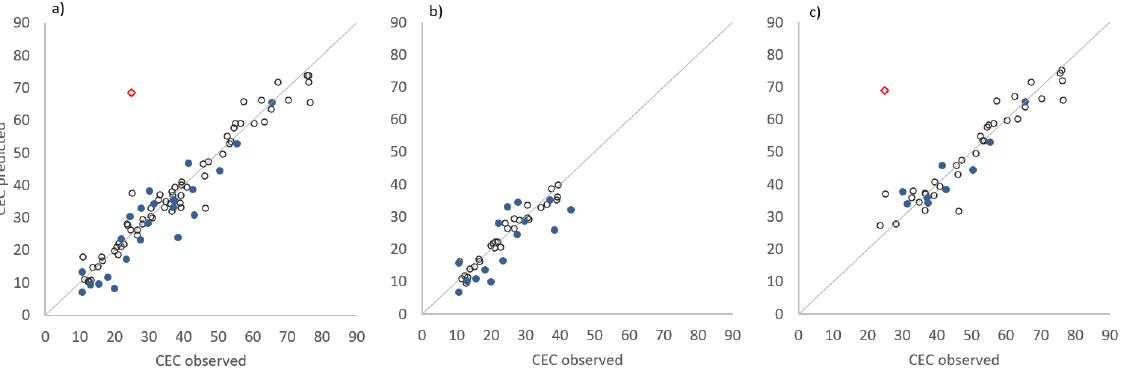
Fig. 2. Predicted cation exchange capacity (CEC, cmol(+) kg -1 ) modelled using soil test cations (STCat cmol(+) l -1 = STCa cmol l -1 2 + STMg cmol l -1 2 + STK cmol l -1 ), pH and soil organic carbon (SOC, %) as predictors for a) the whole data, b) for mineral soils and c) for organic soils plotted against observed CEC (cmol(+) kg -1 ). Open circles represent the results × × of the calibration data and blue circles represent the validation data. Data point excluded from the regression analysis as an outlier is marked with red